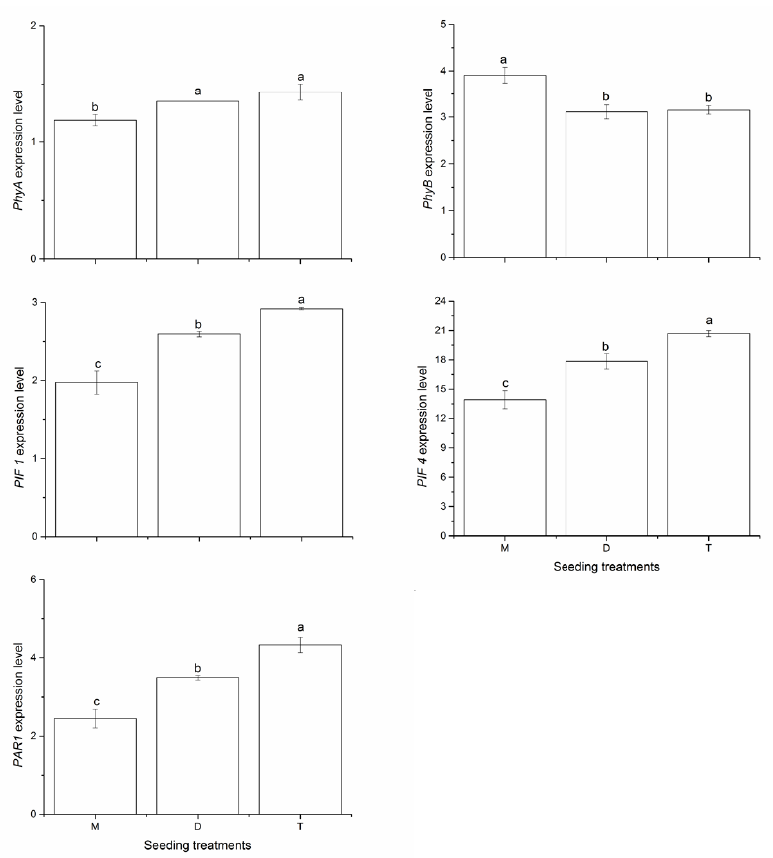
Figure 1. Effects of seeding pattern on the expression of Phy A, Phy B, PIF 1 , PIF 4 and PAR 1 genes at the flowering and pegging stage in 2018. Mean values marked followed by different letters differ significantly at p < 0.05. M, monoseeding, D, double seeding, T, triple seeding .